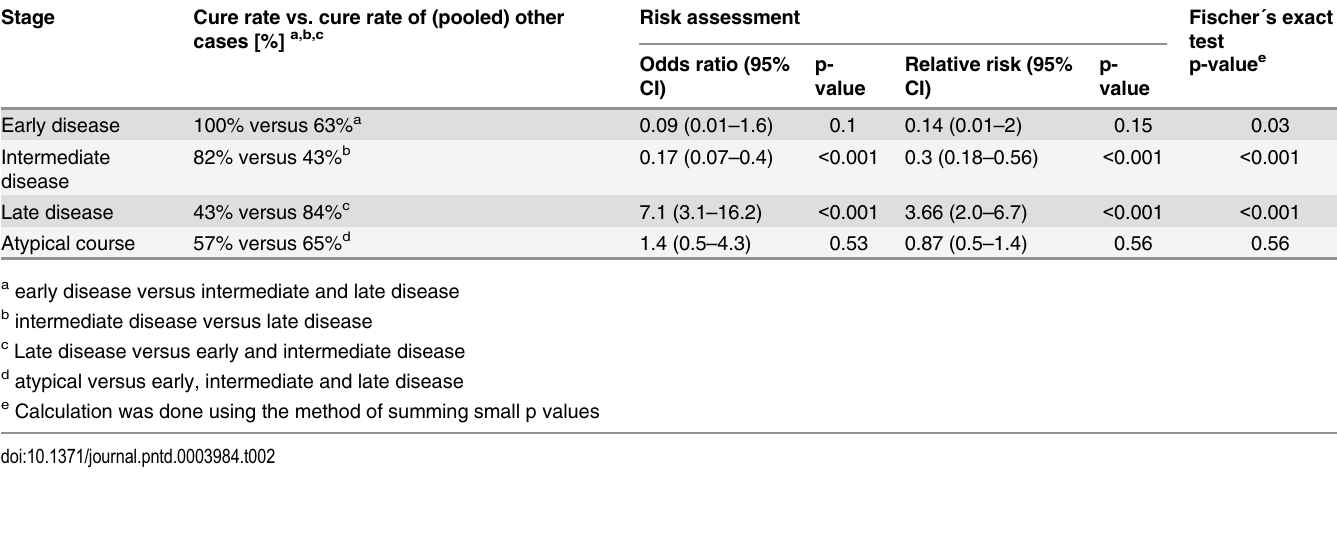
Table 2. Comparison of outcomes in different groups.